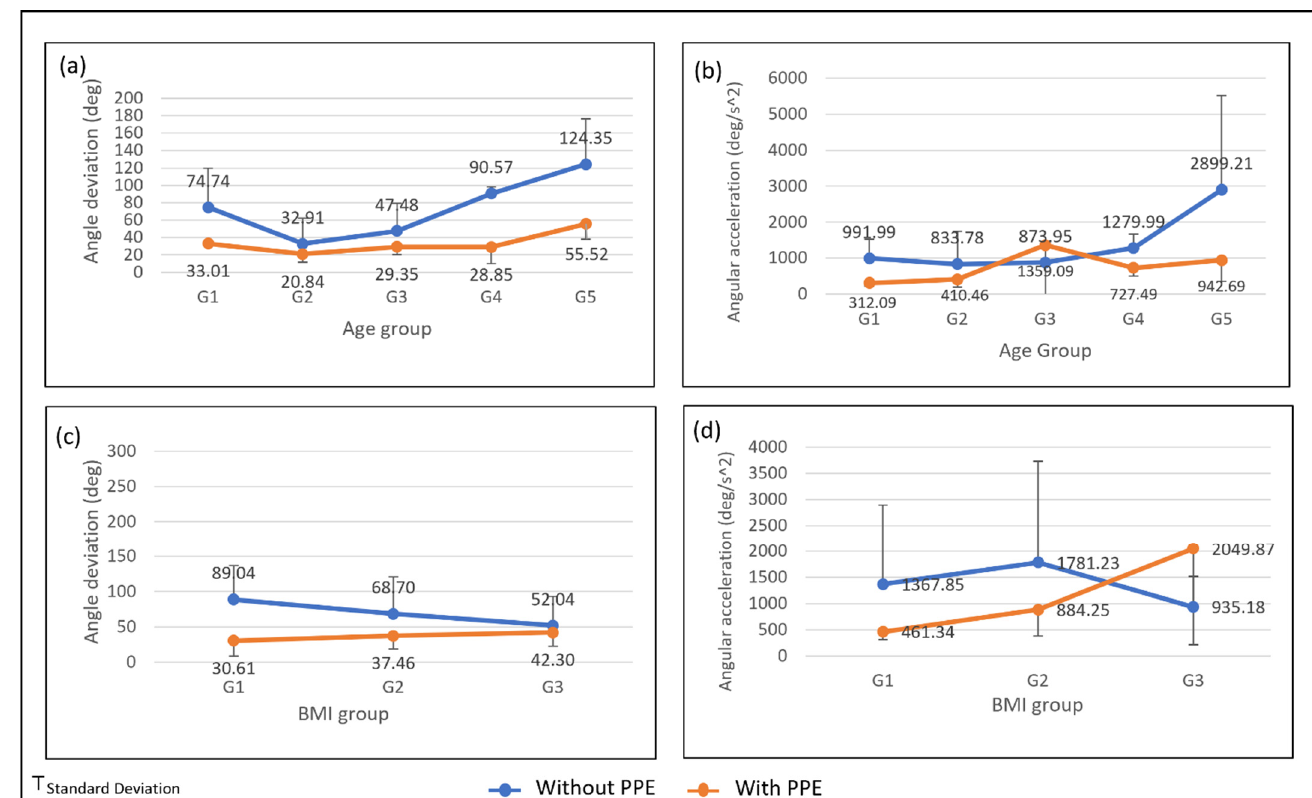
Figure 7. The average and standard deviation of thorax extension for ( a ) angle deviation by age group; ( b ) angular acceleration by age group; ( c ) angle deviation by BMI group; and ( d ) angular acceleration by BMI group.